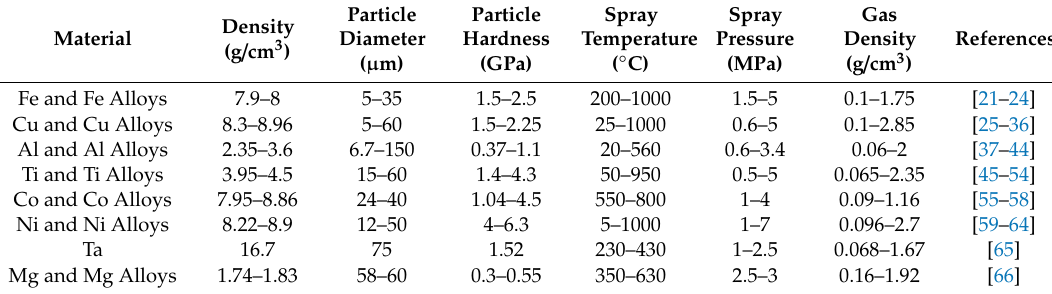
Table 1. Materials and processing conditions employed for the present study.